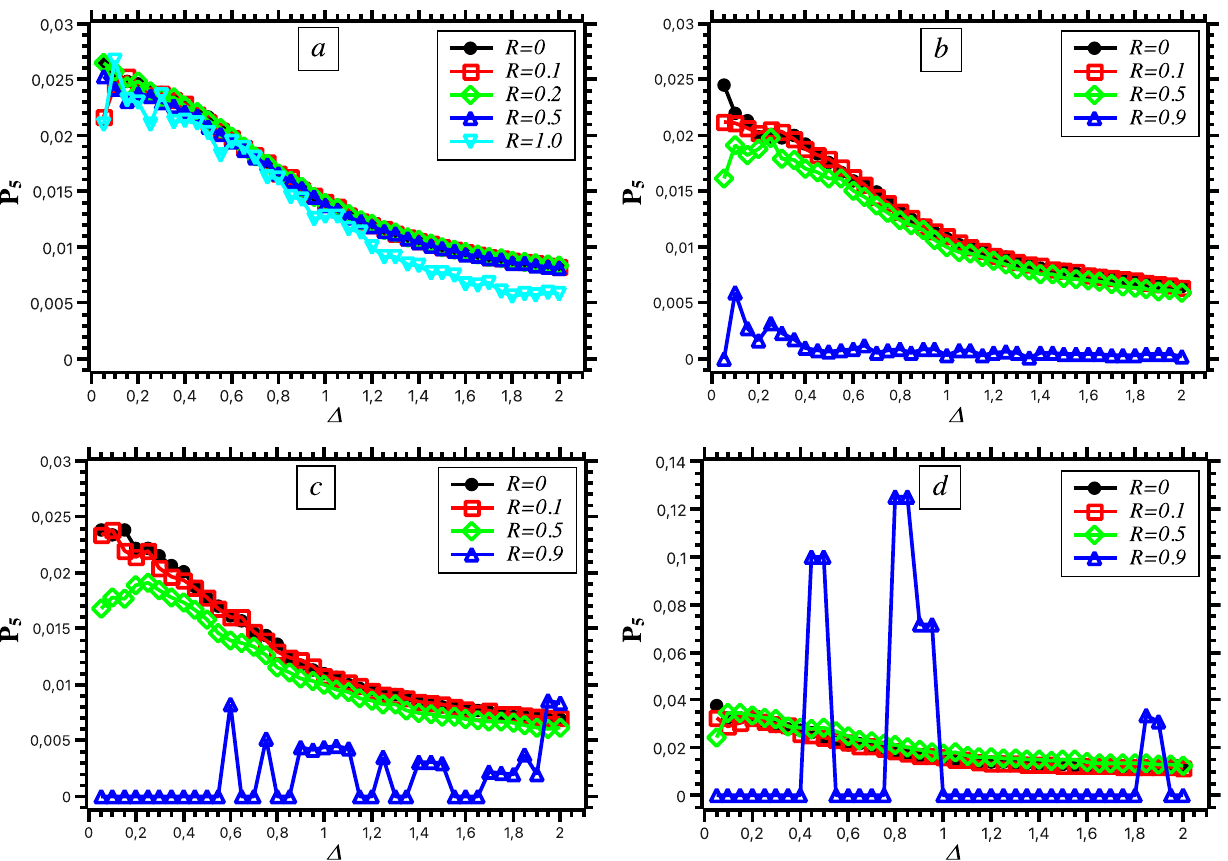
Fig. 4 The degree of alignment P 5 for the five points as a function of the disbalance Δ at the different values of the threshold R for a square ( a ) and for an ellipse with the different eccentricities e = 0 ( b ), e = 0 . 2 ( c ) and e = 0 . 5 ( d )